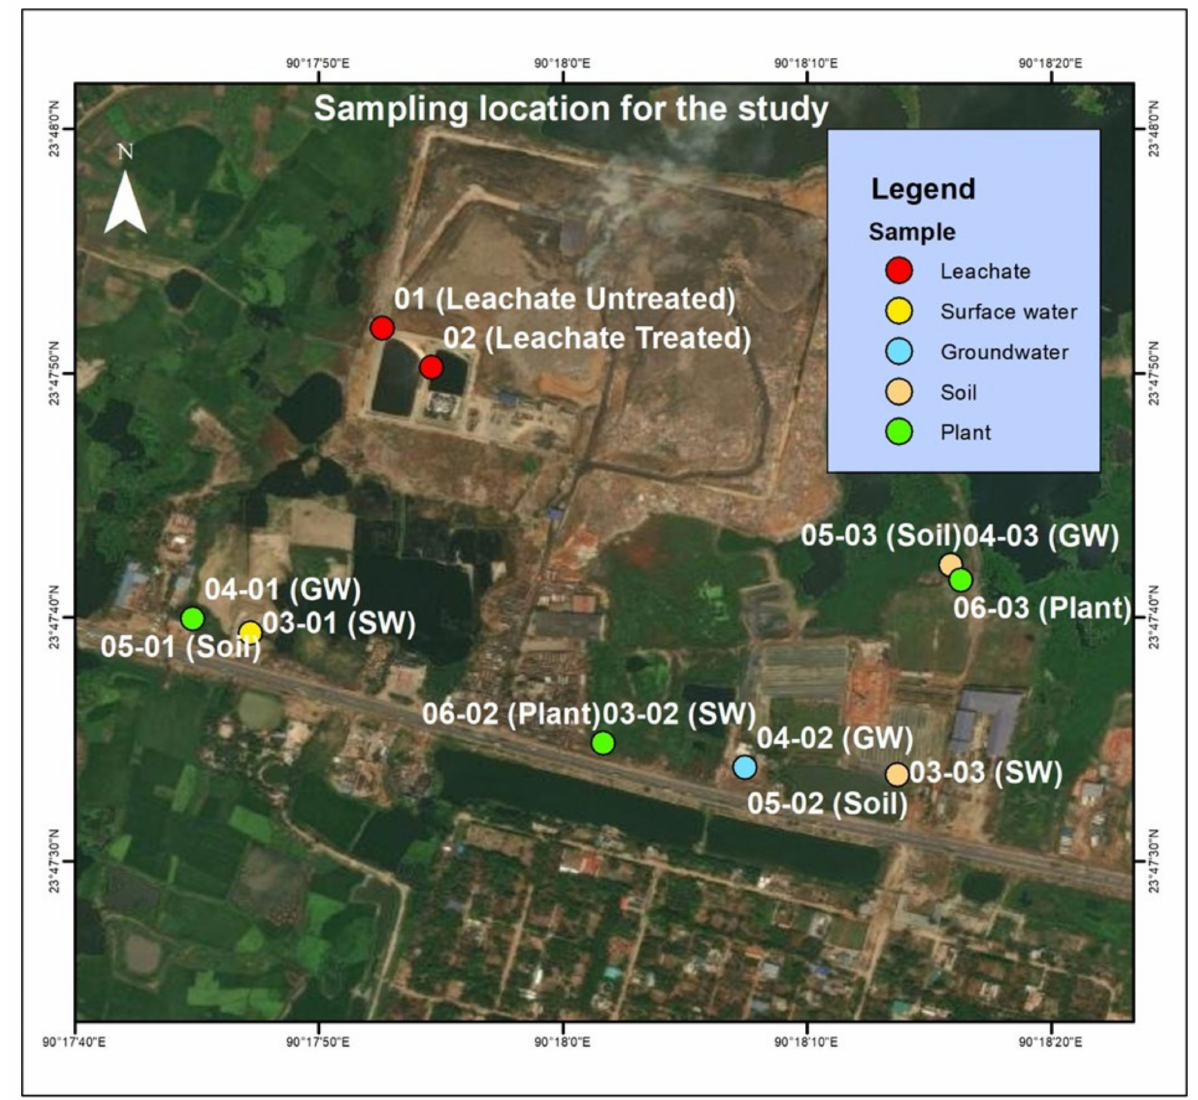
Figure 2. Sampling locations of the study